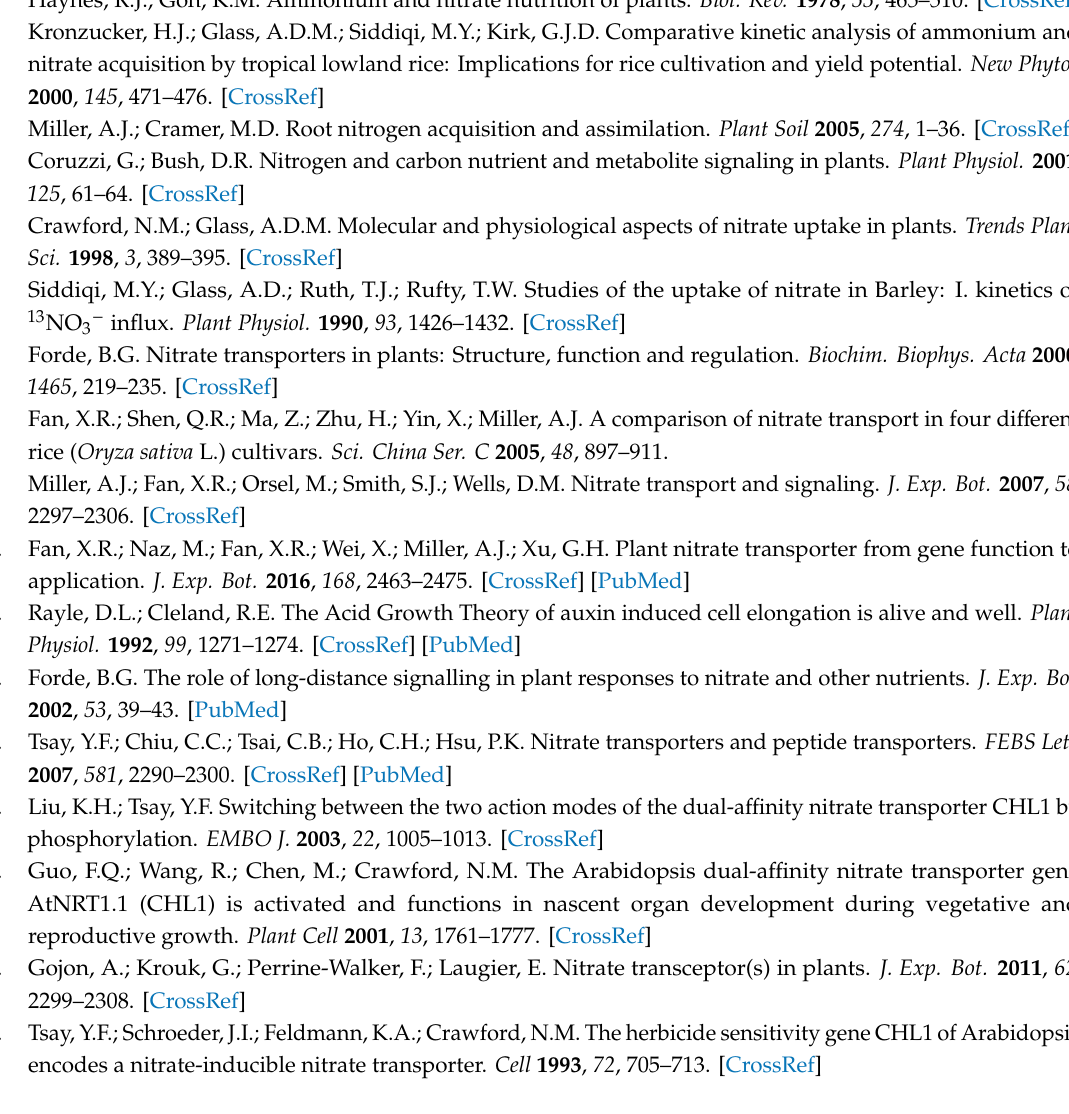
in di ff erent barley lines. Figure S3. Homology analysis of NRT2s genes. Figure S4. The relative expression of HvNRT2s in di ff erent plants parts under 0.2mM NH 4 + and 0.2mM NO 3 − treatments. Figure S5. Phosphorus (P) and iron (Fe) concentrations in di ff erent plant parts under 0.2 mM NH 4 + and 0.2 mM NO 3 − treatments. Figure S6. The characterization of all barley lines under 10 mM NH 4 + condition after 10 mM NH 4 + / NO 3 −